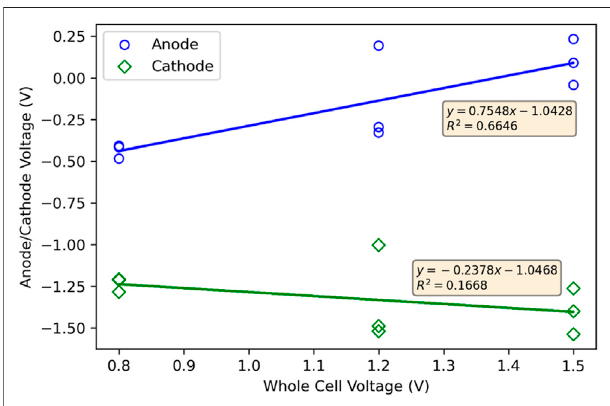
FIGURE 5 | In fl uence of cell voltage on anode (blue circles) vs. cathode (green diamonds) half-cell voltages. The majority of the shift occurs in the anode voltage indicating the need to operate the cell voltage under